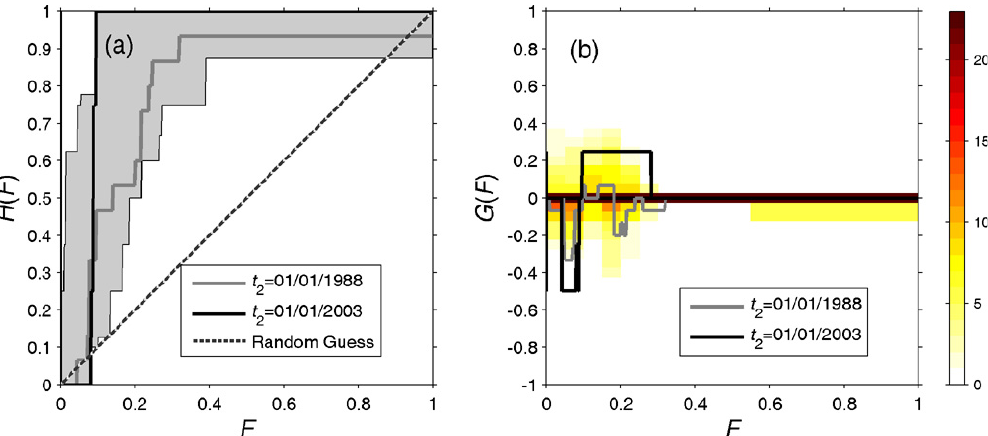
Fig. 4. ROC test of the PI algorithm using “clustering events”. Parameters for the PI calculation and figure captions are the same as in Fig.